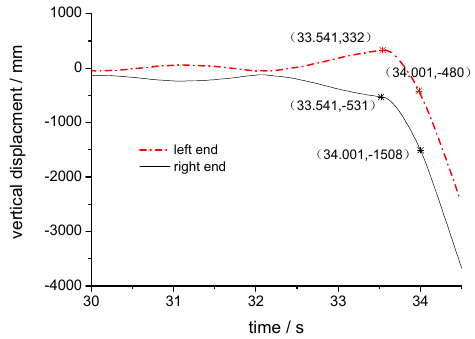
Figure 16. Time history curve of vertical displacement of the end of the main girder.